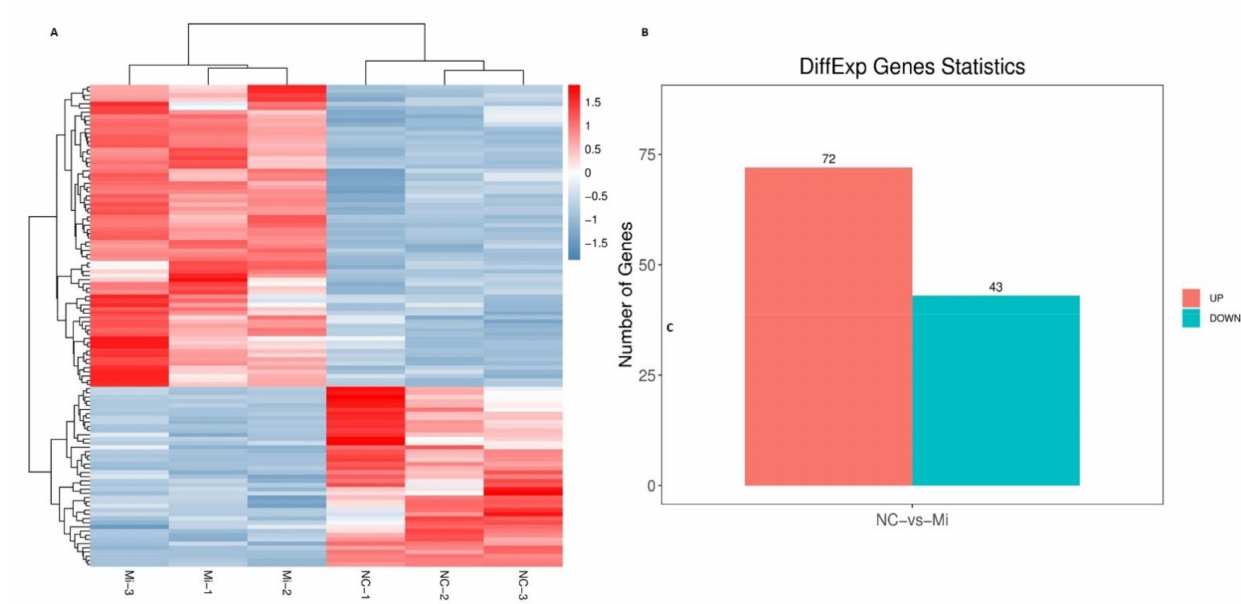
Figure 4. Quantification of DEGs in differentiated bovine adipocytes transfected with bta-miR-149-5p mimic and mimic NC. ( A ) The heatmap gene expression chart for the hierarchical cluster analysis of DEGs between 2 different groups of adipocytes transfected with bta-miR-149-5p mimic (n = 3) and mimic NC (n = 3). ( B ) The bar graph represents the number of DEGs between the 2 groups of differentiated bovine adipocytes transfected with bta-miR-149-5p mimic (n = 3) and mimic NC (n = 3). The red shows the number of upregulated genes and blue represents the number of downregulated